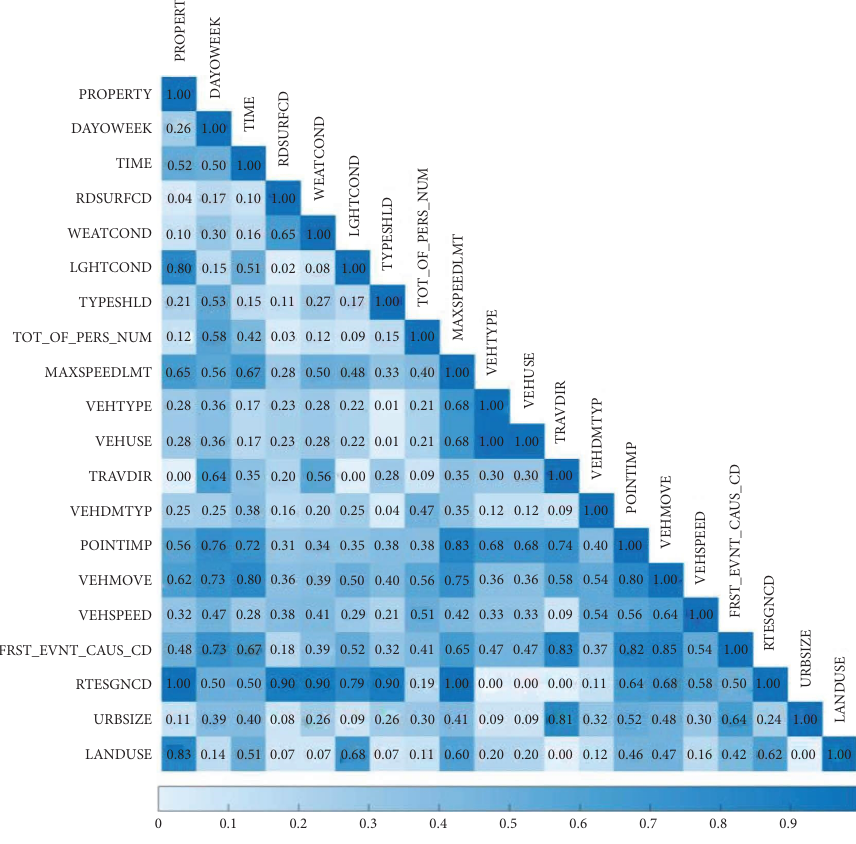
Figure 2: Te MI matrix of the 20 variables for the preliminary